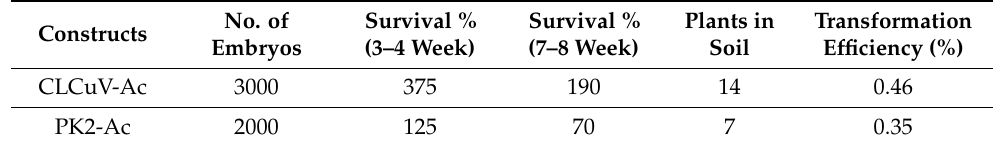
Table 3. Transformation efficiency of constructs in cotton variety